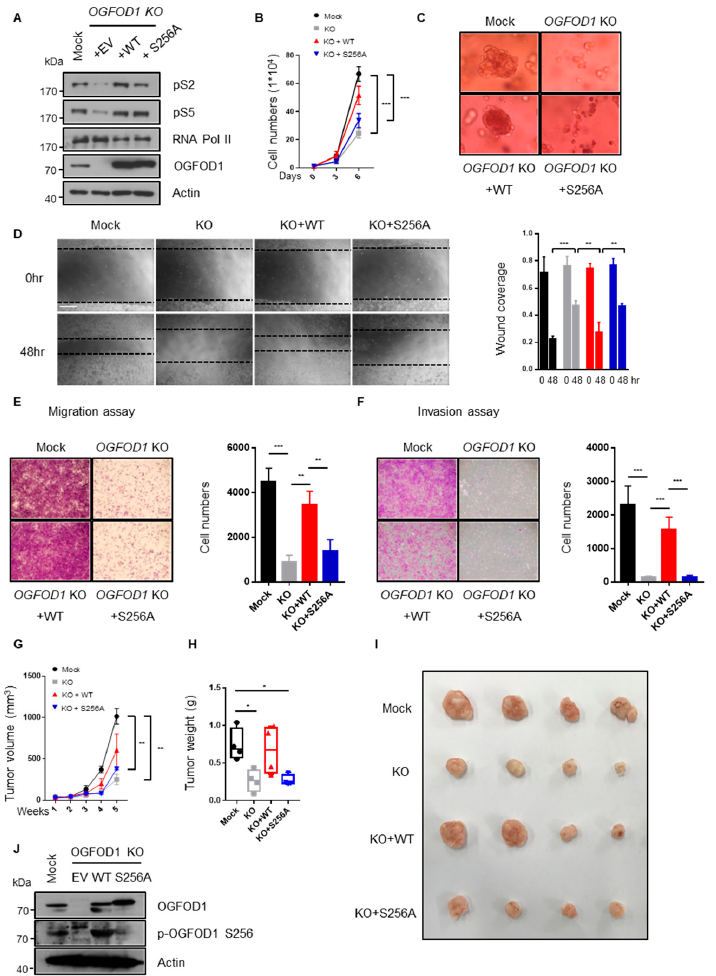
Figure 7. Serine 256 of OGFOD1 has a pivotal role in oncogenic properties. ( A ) Protein levels of OGFOD1 backup in OGFOD1 KO MDA-MB-231 cell lines. ( B ) Proliferation rate of each of